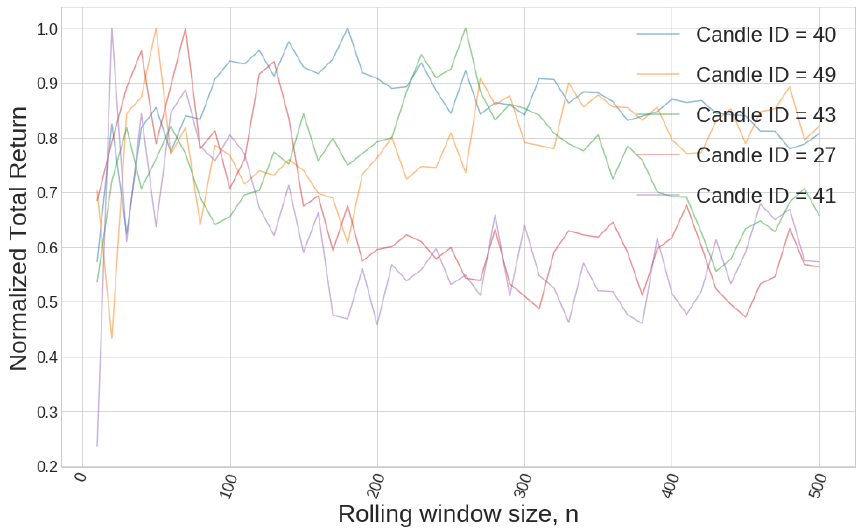
Figure 3. There is not a clear pattern of how the parameter n affects the performance of different